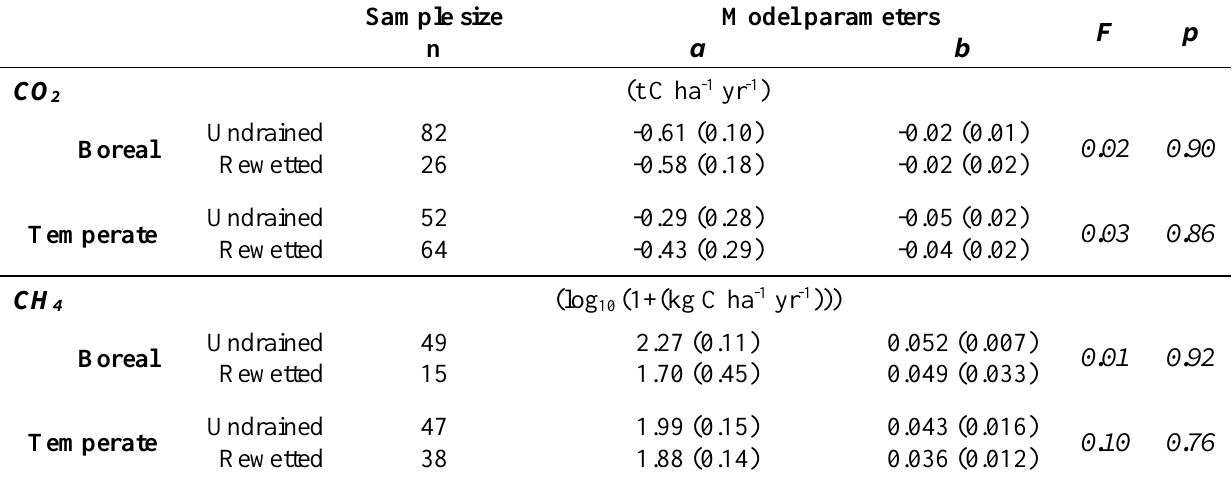
Table 1. Results of General Linear Models (model equations: flux = a + ( b × MWTL )) used to test for homogeneity of regression slopes between undrained and rewetted sites in the boreal and temperate climate zones. Test results are given as F and p values. Standard errors of the model parameters are shown in parentheses. Note: sample size (n) includes all annual flux measurements (i.e. not averaged multi-year datasets from the same site) recorded in the Wetlands Supplement database and, therefore, differs from the sample sizes described in Figure 3.